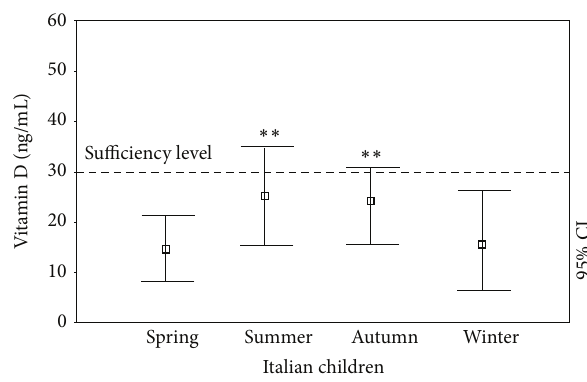
Figure 2: 25(OH)D levels (ng/mL) in Italian children and ado- lescents during different seasons in the cross-sectional evaluation (versus spring value). ∗ 𝑃 < 0.05 ; ∗∗ 𝑃 < 0.005 ; ∗∗∗ 𝑃 < 0.001 .